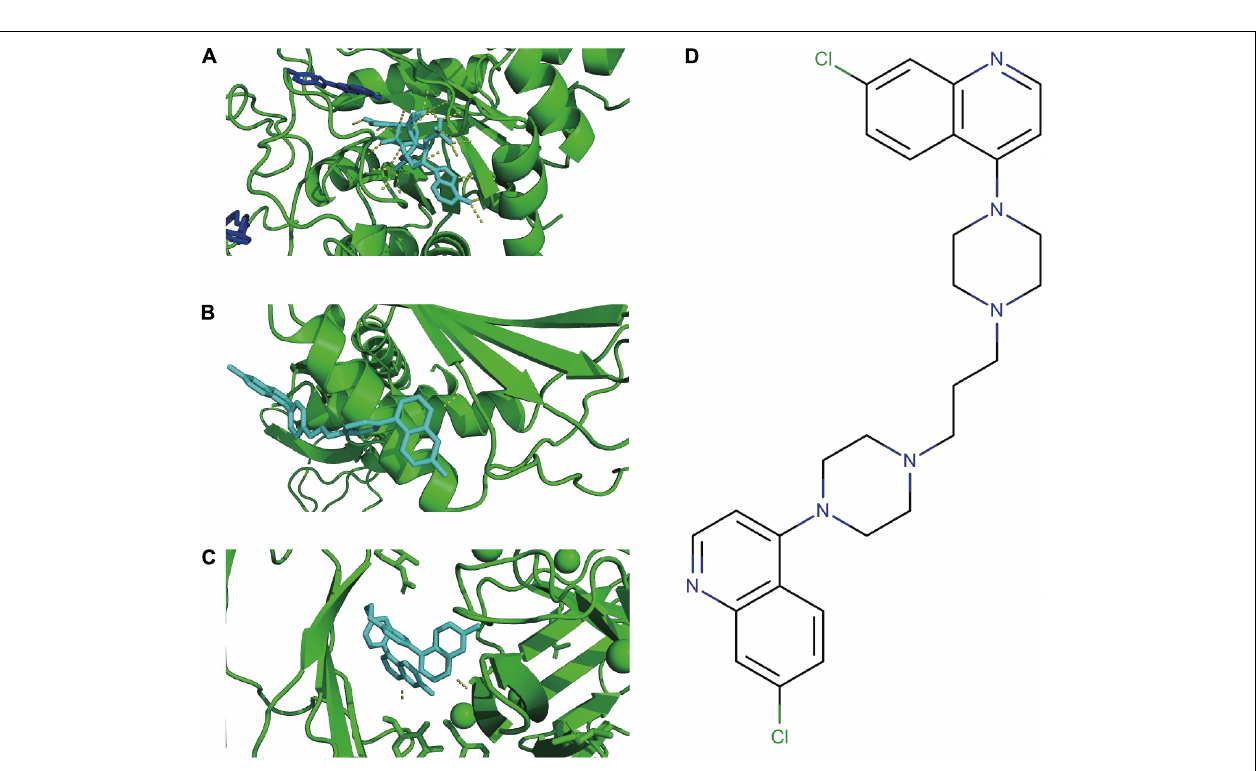
FIGURE 7 | Molecular docking. Docking conformation of DB13941 with AKR1C3 (A) , DDIT4 (B) , LAMP2 (C) . The compound structure of DB13941 (D) .